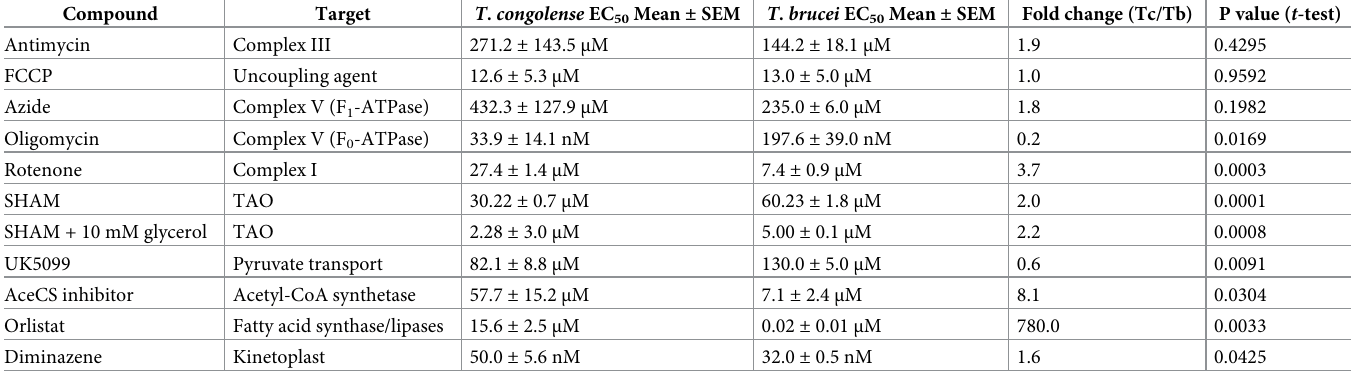
Table 1. Comparative analysis of sensitivity to metabolic inhibitors in T . congolense and T . brucei . Abbreviations: FCCP, carbonyl cyanide-p-trifluoromethoxyphenyl- hydrazone; SHAM, salicylhydroxamic acid; TAO, trypanosome alternative oxidase; AceCS, acetyl-CoA synthetase.